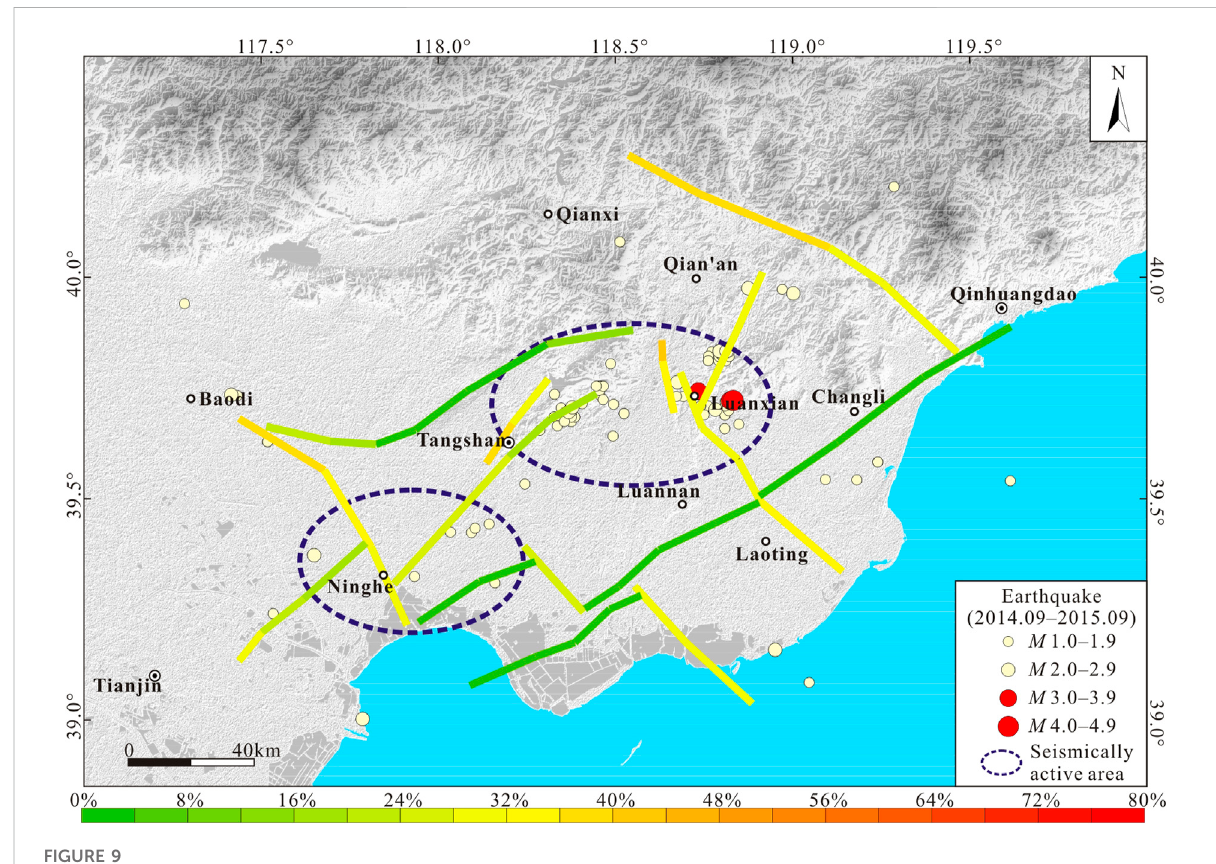
FIGURE 9 The fault slip potential on the main faults in Tangshan seismic region in stage